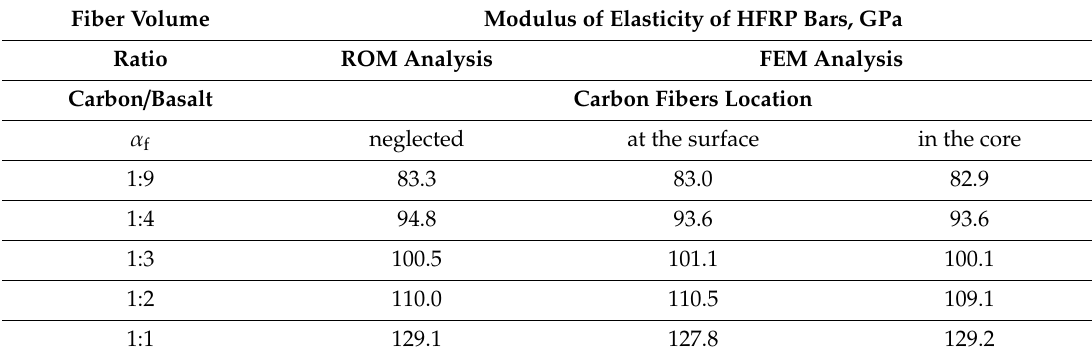
Table 1. Tensile modulus of elasticity of hybrid fiber reinforced polymer (HFRP)